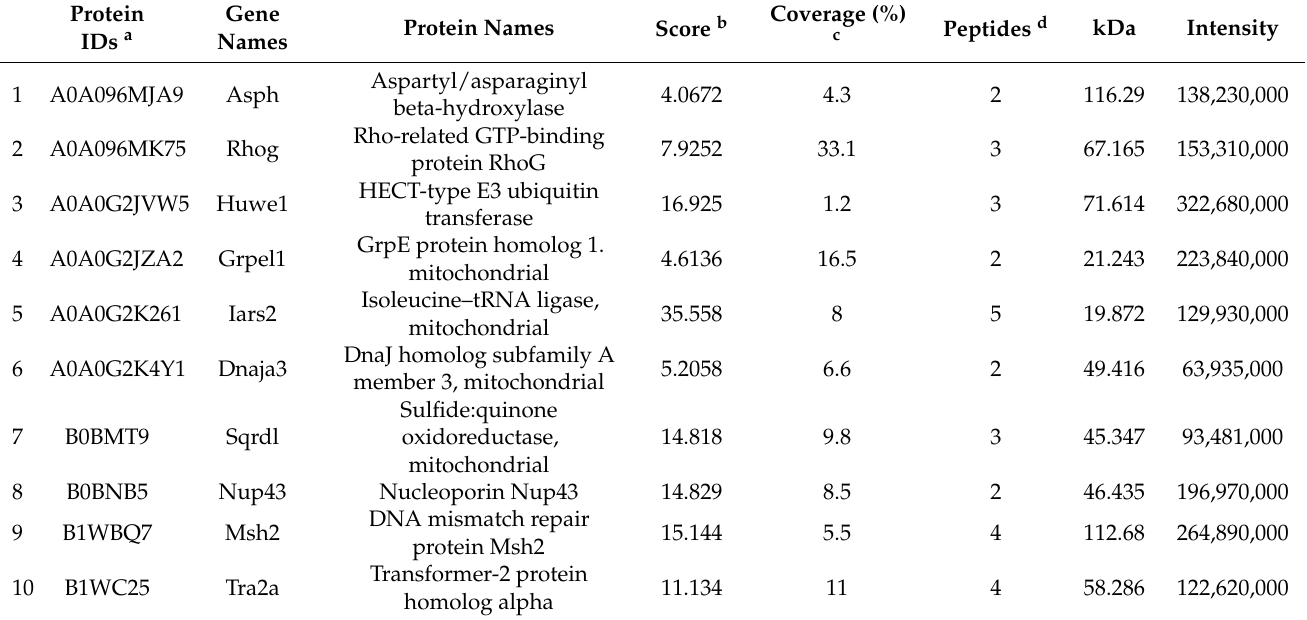
Table 4. nLC-MS identified HepG2 proteins that are found in control cells and not in EO-treated